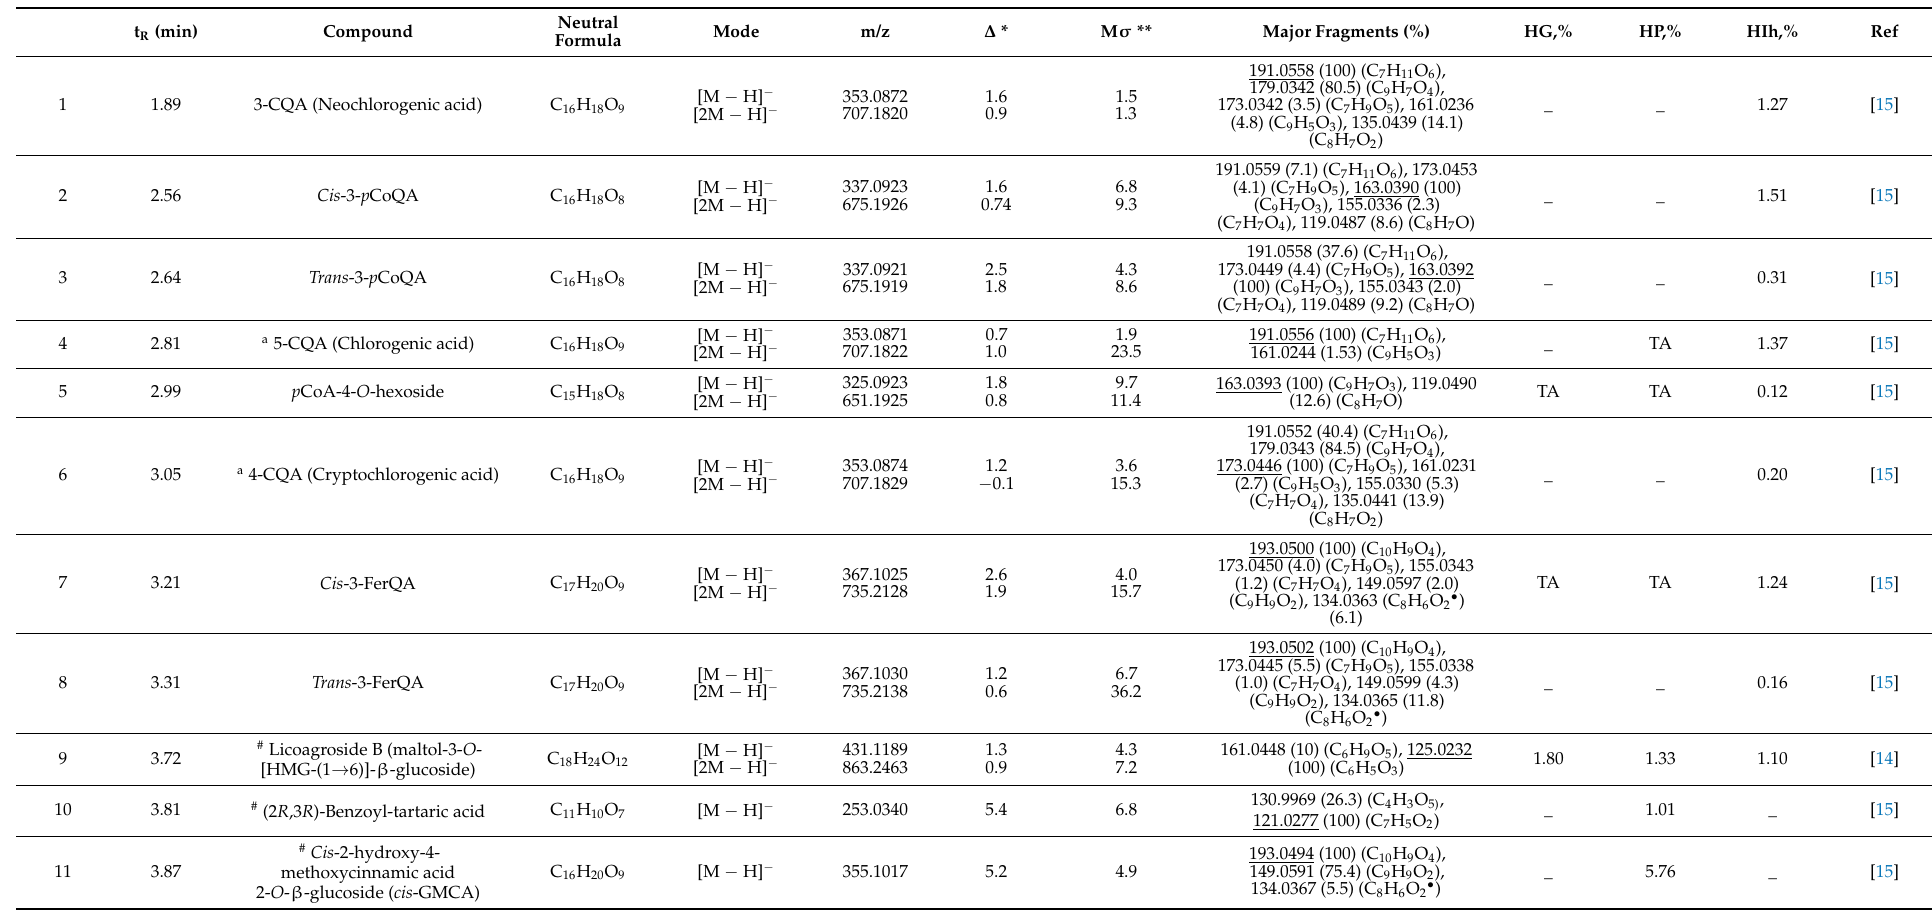
Table 1. Non-saponin compounds identified and quantified in Herniaria glabra (HG), H. polygama (HP), H. incana herb (HIh) purified extracts using UHPLC-QTOF-